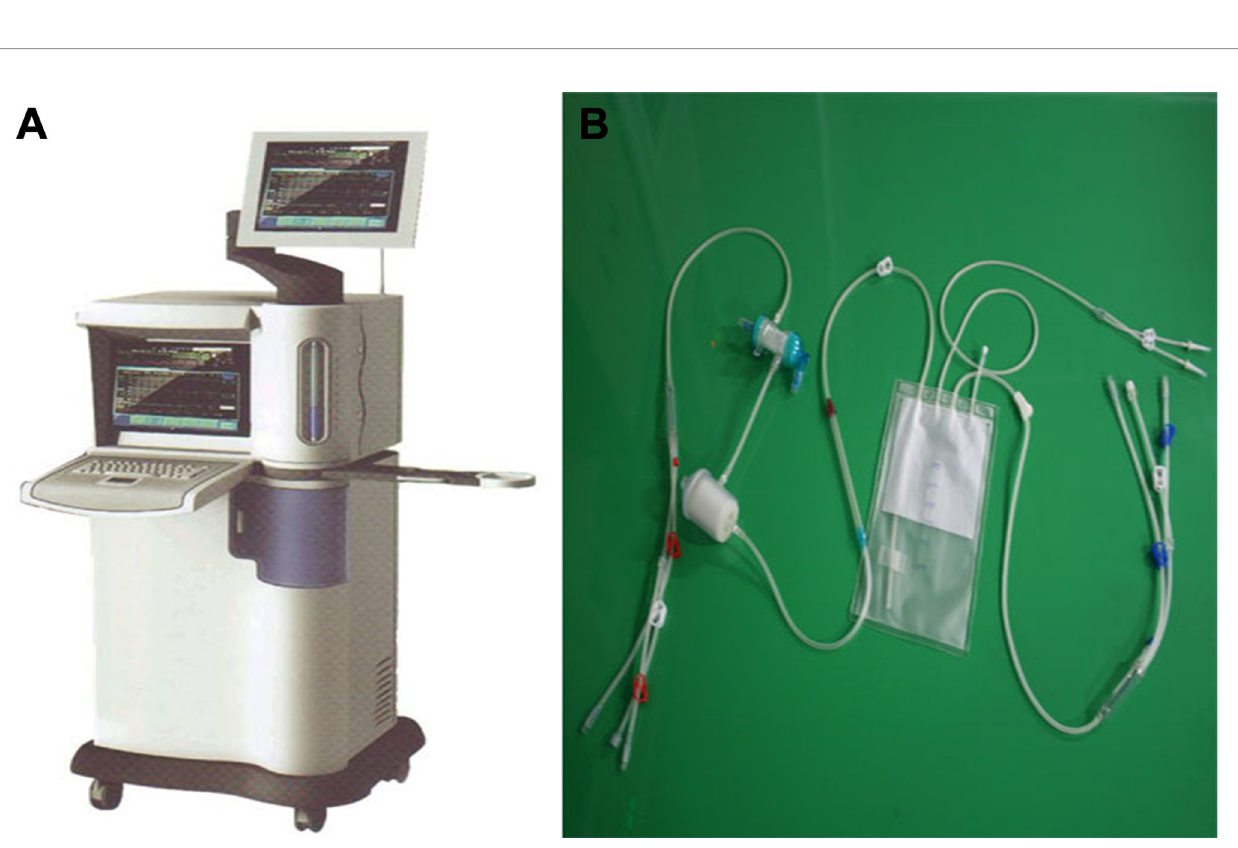
FIGURE 2 | BR-TRG-I type high-precision hyperthermic intraperitoneal perfusion chemotherapy (HIPEC) treatment system by way of BHPC application. (A) The BR- TRG-I type high precision hyperthermic perfusion intraperitoneal treatment device. (B) The BR-TRG-II type high precision hyperthermic perfusion intraperitoneal treatment pipeline.